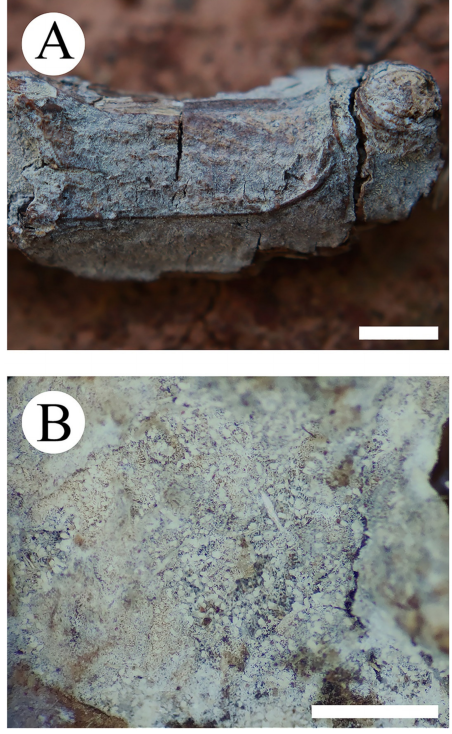
Figure 3. Basidiomata of Trechispora murina (holotype CLZhao 11752): the front of the basidiomata ( A ), characteristic hymenophore ( B ). Bars: ( A ) = 5 mm and ( B ) = 1